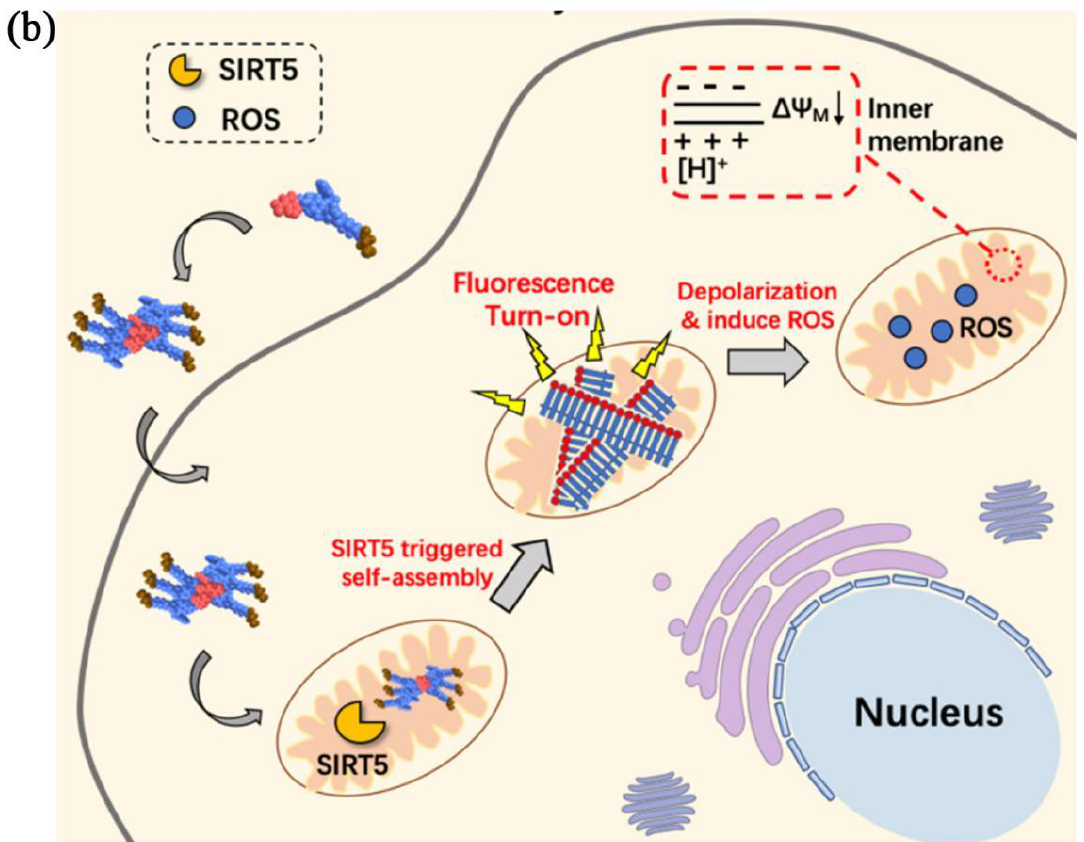
Figure 1. IEISAP for fluorescence imaging. ( a ) Molecular structures of the soluble precursor and the fiber-forming building block. The soluble precursor can be desuccinylated by SIRT5 to generate the fiber-forming building block. ( b ) Scheme illustrating the intracellular fiber formation in mitochondria via the specific interaction of the internalized peptide precursors with the SIRT5 enzyme, as well as the effect of the formation of nanofibers on the depolarization of mitochondrial membrane potential and promotion of ROS generation. Reprinted/adapted with permission from [44]. Copyright 2020, American Chemical